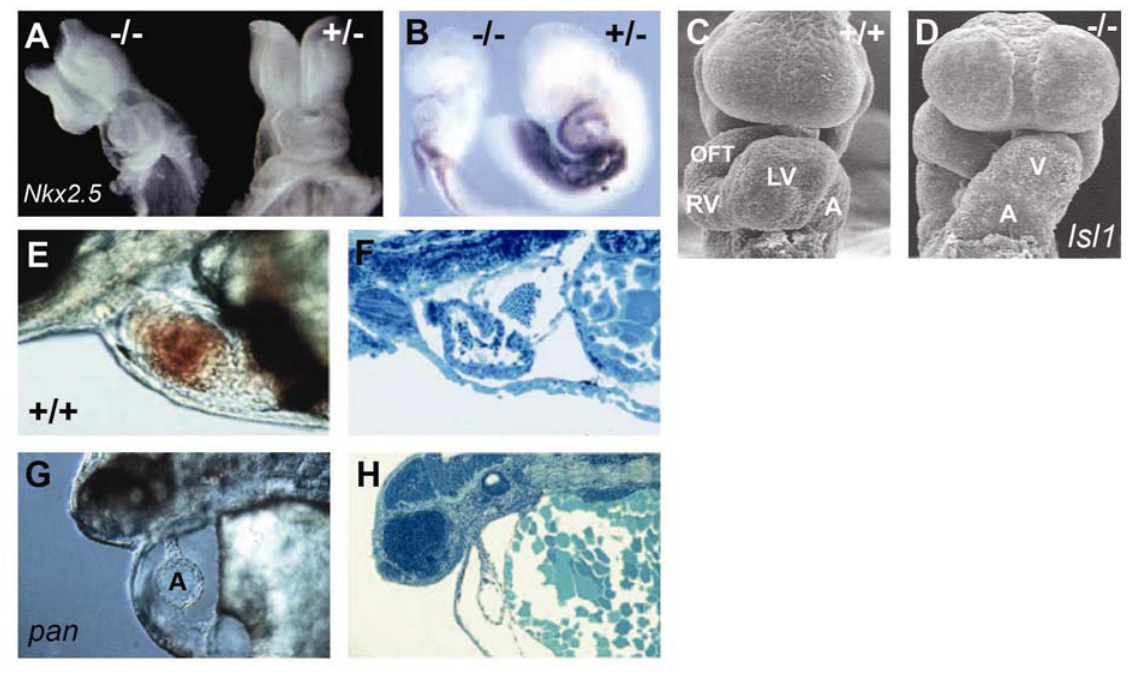
FIGURE 2. Specification of the ventricular chambers. The left and right ventricles are, for the most part, formed from distinct cardiomyocyte progenitor pools. The primary heart field/first lineage contributes to the left ventricle, while the second lineage contributes to the right, as demonstrated by the loss-of-function phenotypes for the early cardiac markers Nkx2.5 and Isl1, respectively. (A) Whole mount Nkx2.5 -/- (left panel) and Nkx2.5 +/- (right panel) E8.5 embryos. In embryos lacking Nkx2.5, the linear heart tube forms, but is morphologically abnormal and does not form ventricular tissue appropriately. (B) In situ hybridization analysis for Hand1 on whole Nkx2.5 -/- (left panel) and Nkx2.5 +/- (right panel) embryos. Hand1 predominantly marks the left ventricle and this expression is lost in the Nkx2.5 -/- embryo, reflecting a defect in the primary heart field/first lineage. Scanning electron micrographs of wildtype (C) and Isl1 -/- (D) E9.5 embryos. Isl1 -/- embryos form only a single ventricular chamber and lack outflow tract and right ventricular components, reflecting a defect in the anterior heart field/second lineage. (E–H) Whole mount (E,F) and sections through (G,H) wildtype (E,G) and pandora ( pan ) (F,H) zebrafish mutant embryos (48 hpf). Zebrafish have only a single ventricle, formation of which appears to be regulated by the pan locus since pan mutants lack ventricular tissue forming only a bulbous atrial-like chamber and outflow tract. LA, left atrium; LV, left ventricle; RA, right atrium; RV, right ventricle; V, ventricle; OFT, outflow tract; A, atrium. A is reproduced from Lyons et al.[13], ©1995; B is reproduced from Biben and Harvey[110], ©1997 with permission from Cold Spring Harbor Laboratory Press; C and D are reproduced from Cai et al.[7], ©2003 with permission from Elsevier; E–H are reproduced from Stainier et al.[18], ©1996 with permission from the Company of Biologists